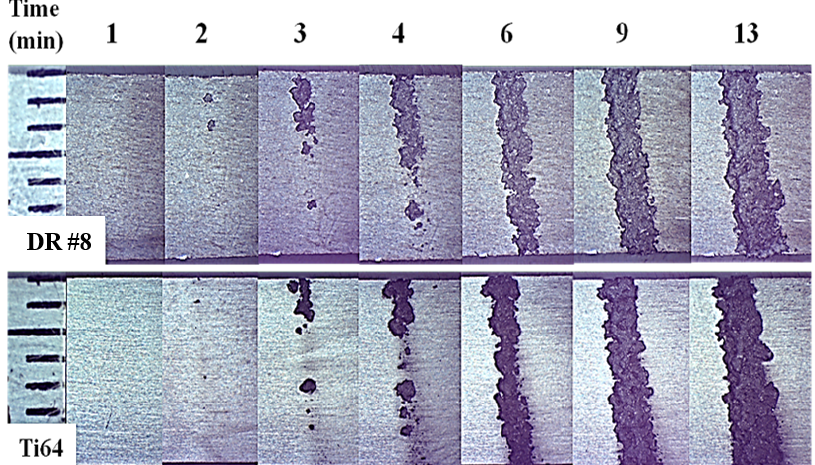
Figure 13. Macrographs of test 2 show the change in the exposed surface of DR #8 and non-treated Ti64 with time during the LIE with 460 µm droplets at 350 m/s impact